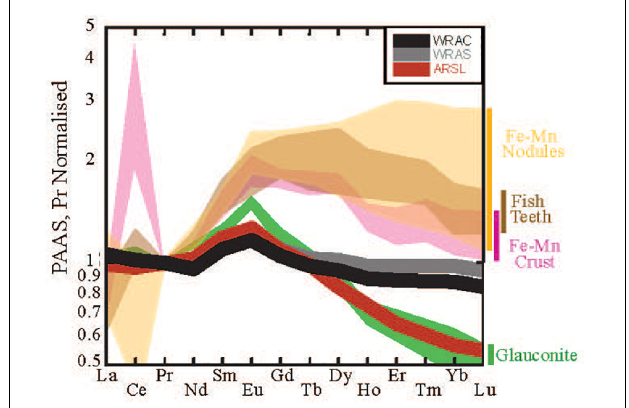
FIGURE 8 | Range of shale-normalized REE patterns of potential authigenic host phases including glauconite (green, Huggett et al., 2017), Fe-Mn nodules (yellow, Bau et al., 2014), hydrogenetic Fe-Mn crusts, (pink, Azami et al., 2018), and fish teeth (brown, Huck et al., 2016). Average river suspended load (ARSL, red), world river average clay (WRAC, gray), and world river average silt (WRAS, black) plotted for comparison (data from Bayon et al., 2015). Normalized to PAAS values of Taylor and McLennan